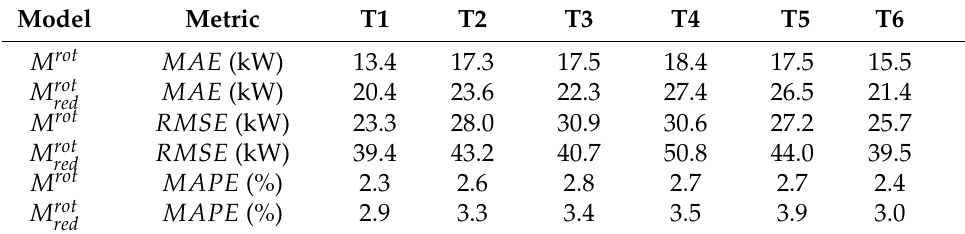
Table 4. Results of the models validation for the rotor speed-power curve in Region 2: WF1. Model